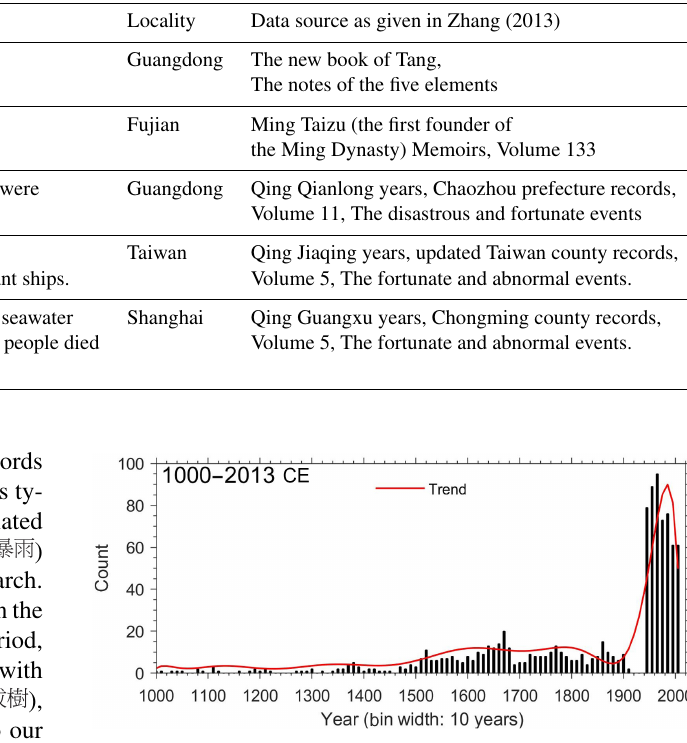
Figure 2. Historical paleotyphoon data compiled over the past 1000 years from China’s historical record and JTWC data for south- eastern China and Taiwan. Each bar in the bar graph represents the collective number of typhoons occurring in any given